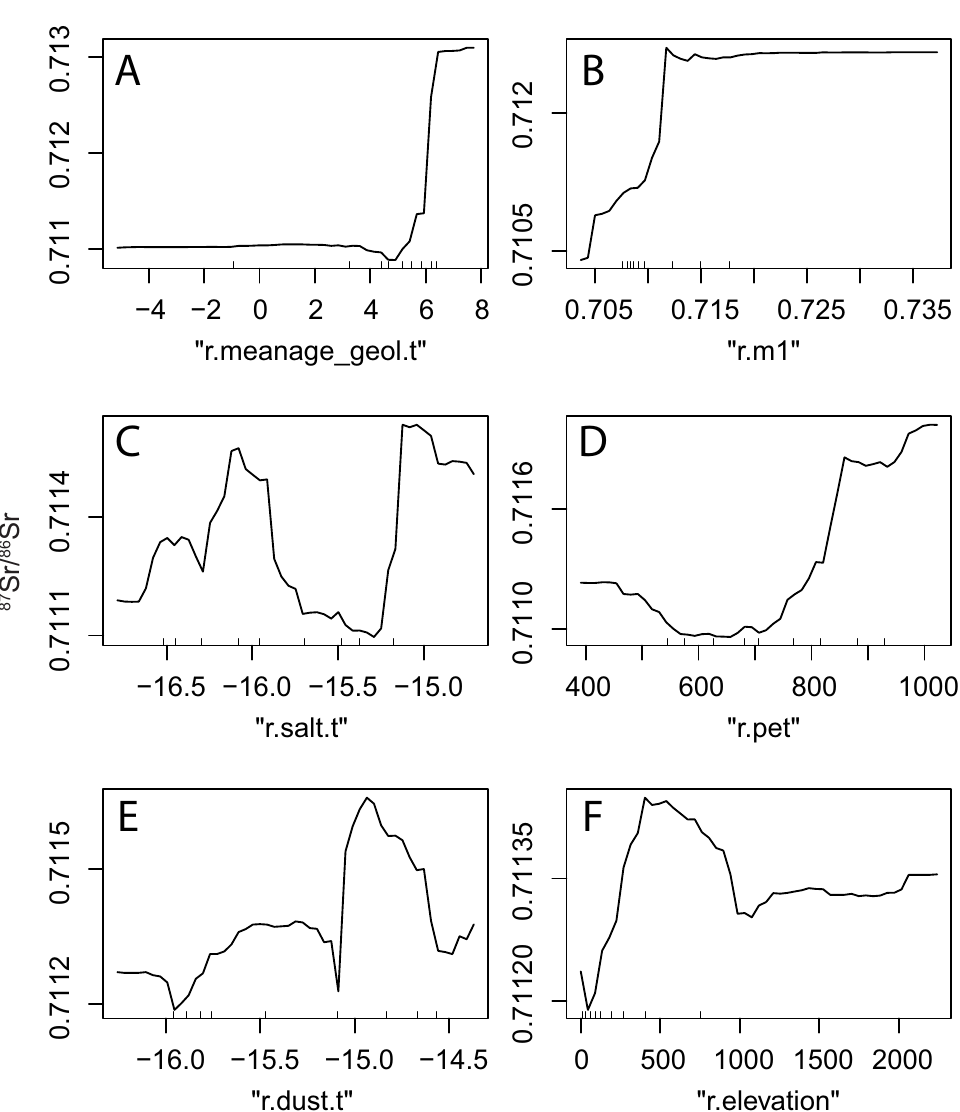
Fig 7. Partial dependence plots for some important variables. A. Log-transformed maximum age of geological units (R.meanage_geol.t) from GLiM database (r.meanage_geol.t in Table 2), B. Median prediction of Bataille et al. (2014)’s model applied to Western Europe (r.m1 in Table 1), C. Log-transformed values of Sr flux from sea salt aerosol deposition in t.km -2 .a -1 (r.salt.t in Table 2), D. Potential Evapo-transpiration (r.pet in Table 2), E. Log-transformed values of Sr flux from dust aerosol deposition (r.dust.t in Table 2) and F. Elevation (r.elevation in Table 2). Refer to Tables 1 and 2 for description and sources of each covariate. Hash marks along the x axis show covariate sample decile values. parametric relationships, and cannot account for non-continuous, discrete or non-monoto- nous relationships between variables. Conversely, the random forest regression applied in this work shows multiple forms of linear, non-linear and threshold-based relationships (Fig 7). 87 Sr/ 86 Sr variations are exponentially correlated with the log-transformed maximum age of geological units (r.meanage_geol.t) (Fig 7A). However, the age of geological units only becomes an important control of 87 Sr/ 86 Sr variations for older rock units (age >> 100 Ma) (Fig 7A). This observation is in line with the 48.8 billion year half-life of 87 Rb such that 87 Sr/ 86 Sr ratios of rocks are significantly affected over time periods of several tens of millions